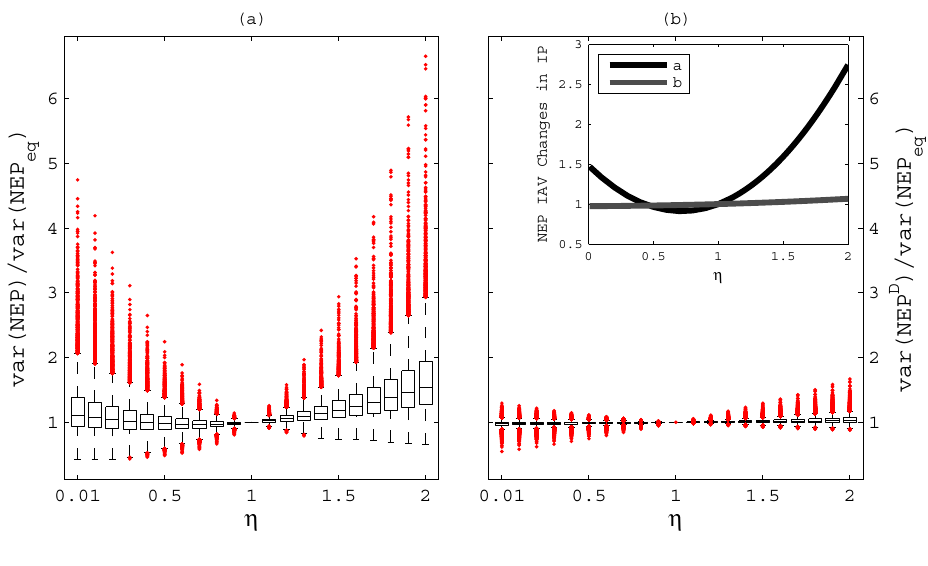
Fig. 5. Influence of distance to equilibrium ( η ) in the inter-annual variability (IAV) of net ecosystem fluxes (a) and in the IAV of the de-trended NEP fluxes (removing the sole recovery from the C pools) (b) . Each vertical rectangular box represents the spatial distribution of the IAV ratio indicated in the yy-axis for Iberian Peninsula (all pixels). Rectangular boxes are bounded by 25 and 75 percentile bottom and top, respectively, while the horizontal line inside indicates the sample median; dashed lines limited by horizontal bars indicate the extent of the remaining data, excluding outliers; dot signs ( • ) indicate statistical outliers. The inset in (b) shows for a spatial average of all the Iberian Peninsula the ratio between the IAV of NEP and the IAV of NEP eq (black line a) and the ratio between the IAV of NEP D and the IAV of NEP eq (grey line b). The regional differences in IAV for the Iberian Peninsula between both approaches as a function of distance to equilibrium are significant.